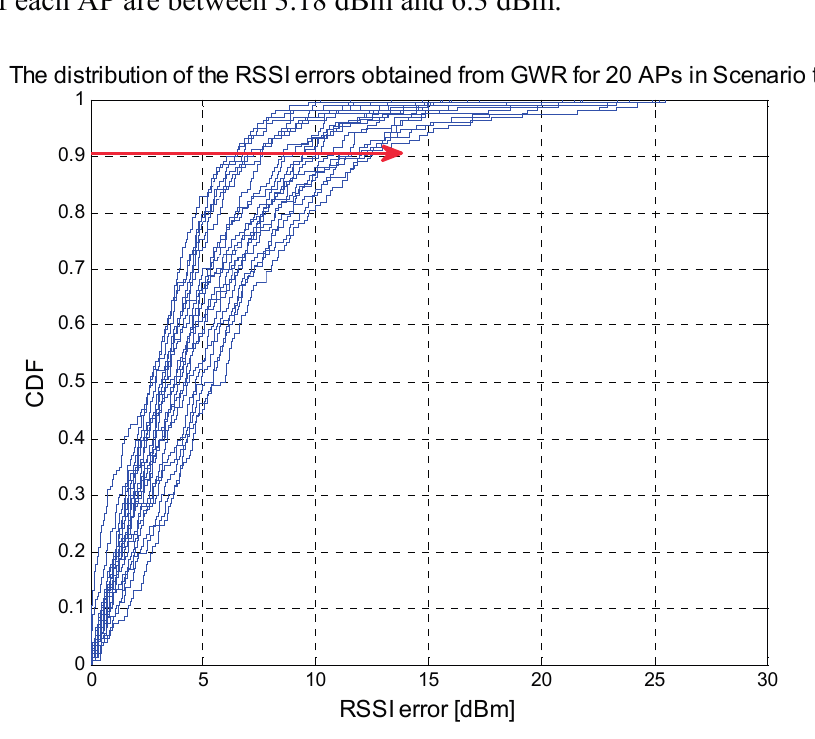
Figure 11. Estimated RSSI errors for testing points in scenario